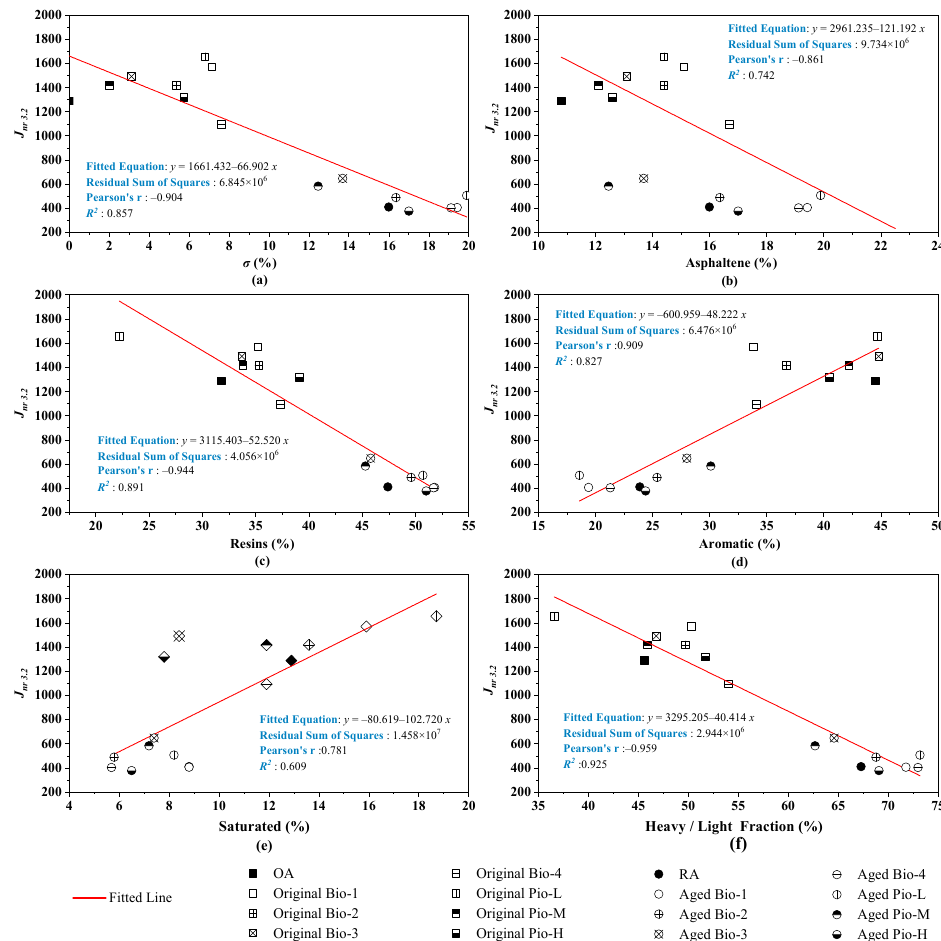
Figure 14. Correlation analysis between the J nr3.2 and fraction indicators. ( a ) σ ; ( b ) asphaltene; ( c )resins; ( d ) aromatic; ( e ) saturated; ( f ) heavy/light.